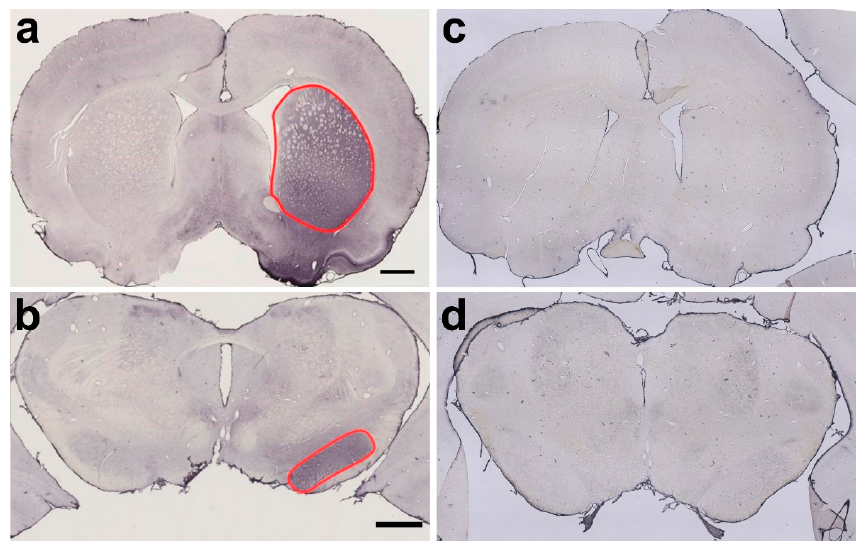
Figure 1. The figure depicts exemplarily 30 µm-thick frontal sections, immunohistochemically stained for cleaved SNAP-25, from a rat brain treated with 1 ng of BoNT-A on the right side one month ( a , b ) previously, and one rat brain treated with vehicle solution only 12 months previously ( c , d ). ( a ) A frontal section from the telencephalon of a BoNT-A-treated rat. The CPu of the right side is outlined in red. ( b ) A frontal section from the midbrain of the same animal. The SNpc is marked in red. ( c ) The frontal section of the telencephalon and ( d ) of the midbrain of a vehicle-treated rat. Note the differences in the strength of the staining in the CPu and the SNpc. The scale bar in ( a ) corresponds to 1 mm in ( a , c ). The scale bar in ( b ) corresponds to 1 mm in ( b , d ).